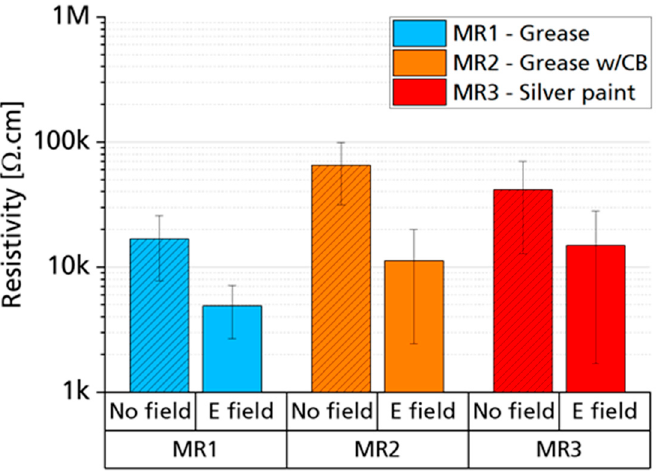
Figure 8. Impact of mold release agent on single disc average resistivity of SWCNT/epoxy 0.01 wt.%.